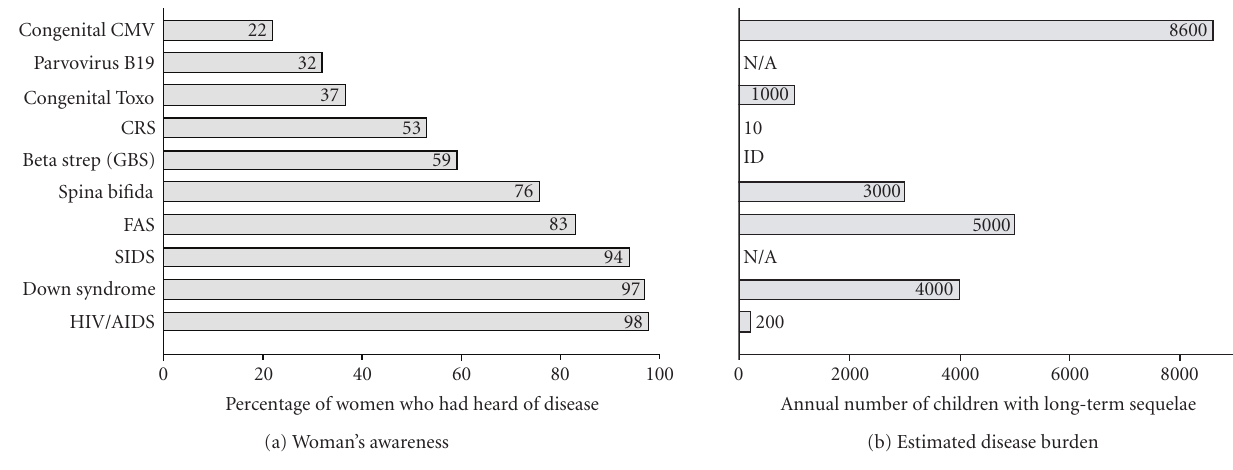
Figure 1: (a) Awareness of congenital CMV and other birth defects and childhood illnesses. (b) Estimates of the annual burden of promi- nent childhood diseases and syndromes in the US (from [7]). Assumes 4 million live births per year and 20 million children < 5 years of age. Childhood deaths were defined as those occurring < 1 year after birth except for Haemophilus influenzae type B (Hib) ( < 5 years) and HIV/AIDS ( < 13 years). Where applicable, numbers represent means of published estimates. All estimates should be considered useful for rough comparisons only since surveillance methodology and diagnostic accuracy varied over di ff erent studies. CMV: cytomegalovirus; Toxo: toxoplasmosis; CRS: congenital rubella syndrome; GBS: group B strep; FAS: fetal alcohol syndrome; SIDS: sudden infant death syndrome; N/A: not applicable because long-term sequelae are not normally associated with the condition; ID: insu ffi cient